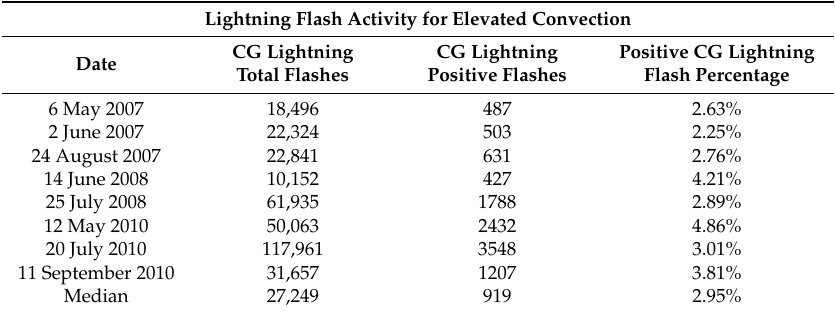
Lightning flash characteristics within the heavy rainfall area for surface based convection